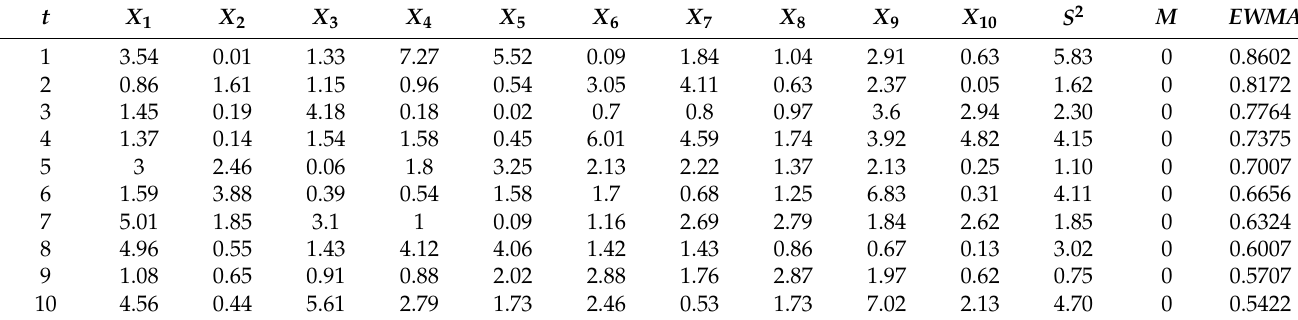
Figure 2. The Bayesian EWMA variance chart under the in-control process. In order to illustrate the detecting power for the variance change, ten new samples of size 10 were collected from a new automatic service system of the bank branch. Installing an automatic service system makes more consistent service time. The process variance will be reduced significantly. Table 9 lists the service time of the ten new out-of-variance-control samples, M t , and EWMA t . Table 9. The new service time from 10 counters in a bank branch.